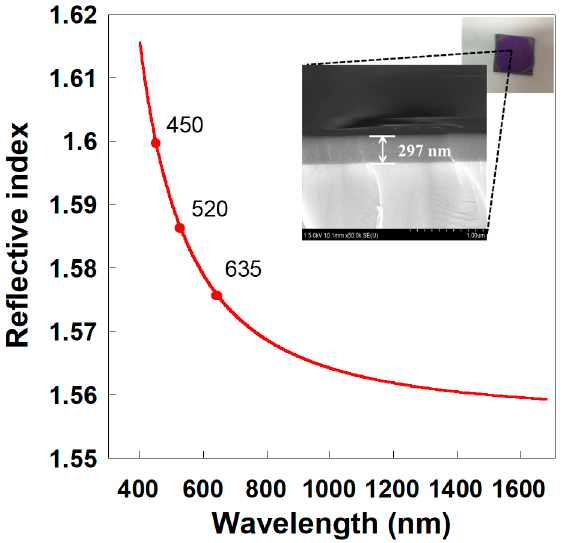
Figure 5. Refractive index of the PSH. The inset images represent the picture and cross-section SEM image of the PSH samples.